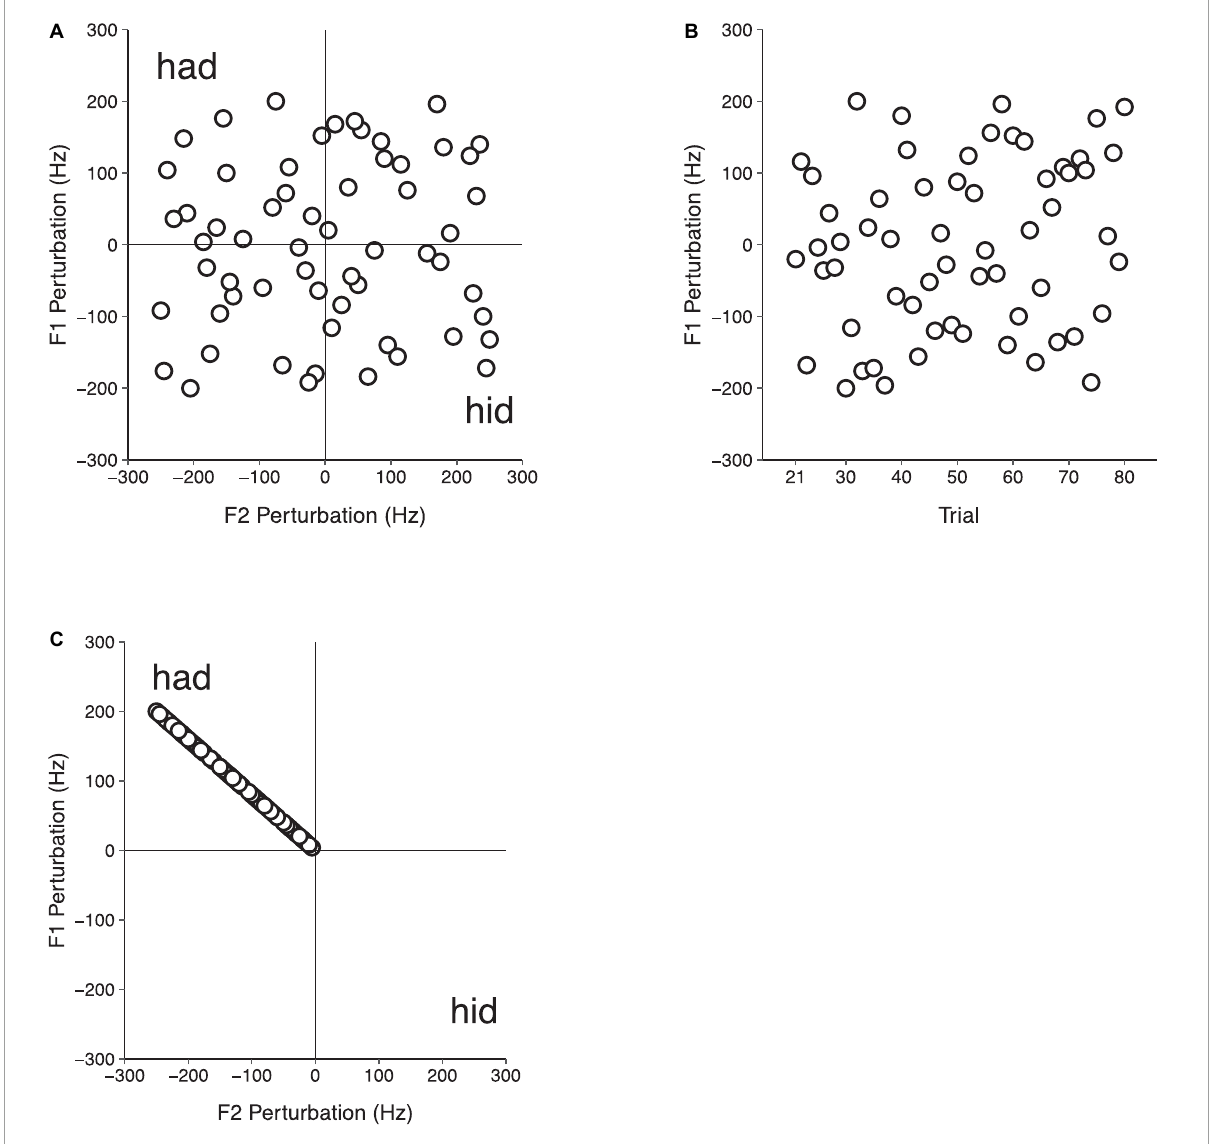
FIGURE2 Auditory feedback perturbation values in the Perturbation phase (trials 21–80) of Experiment 1 in the F1/F2 Random Perturbation Condition (A) , F1-Only Random Perturbation Condition (B) , and F1/F2 Coupled Random Perturbation Condition (C) . In the F1/F2 Random Perturbation Condition, perturbation magnitudes were not related. Half of the perturbations were positive, and half were negative. The overall average perturbation value in F1 and F2 was 0 Hz. In the F1-Only Random Perturbation Condition, only F1 was perturbed. An equal number of random positive and negative F1 perturbations were applied, and the overall average perturbation value in F1 was 0 Hz. In the F1/F2 Coupled Random Perturbation Condition, speakers received feedback that was biased toward the vowel /æ/ in “had” in F1/F2 space. Random perturbation magnitudes in F1 and F2 were related, with F1 and F2 perturbations being applied in multiples of 4 and –5 Hz,